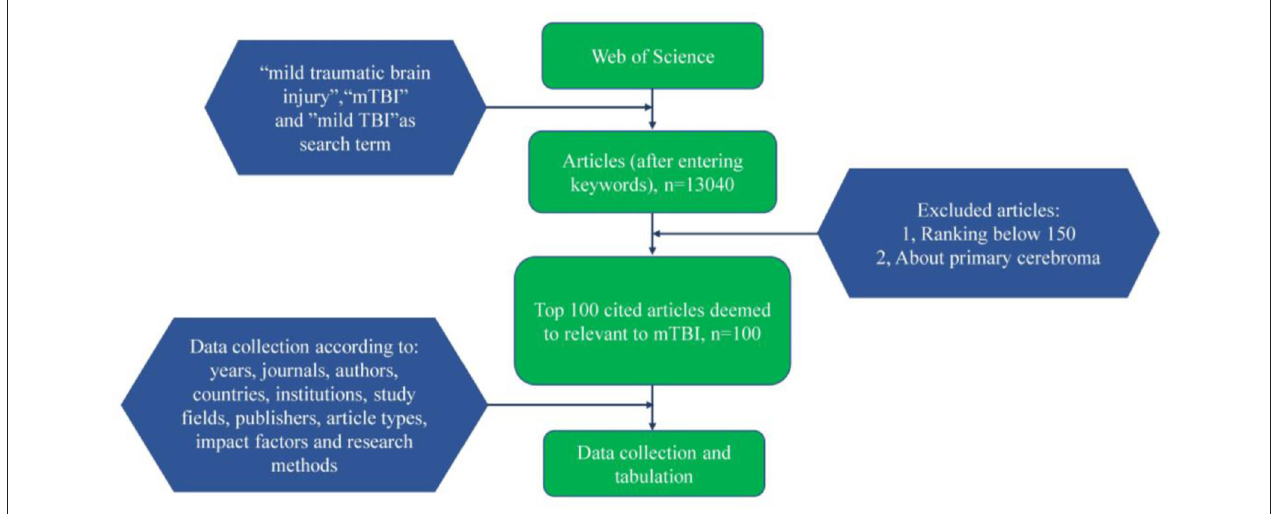
FIGURE 1 | Flow chart showing the methodology used in the